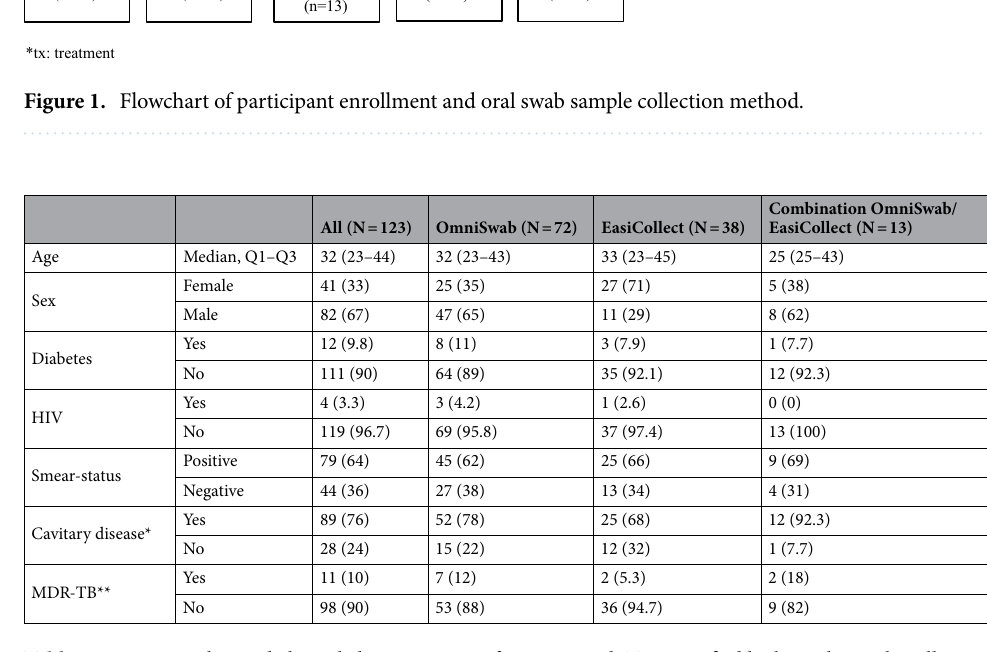
Table 1. Demographic and clinical characteristics of patients with TB, stratified by buccal sample collection method. Results are expressed as n (%), unless otherwise noted. *6 missing. **14